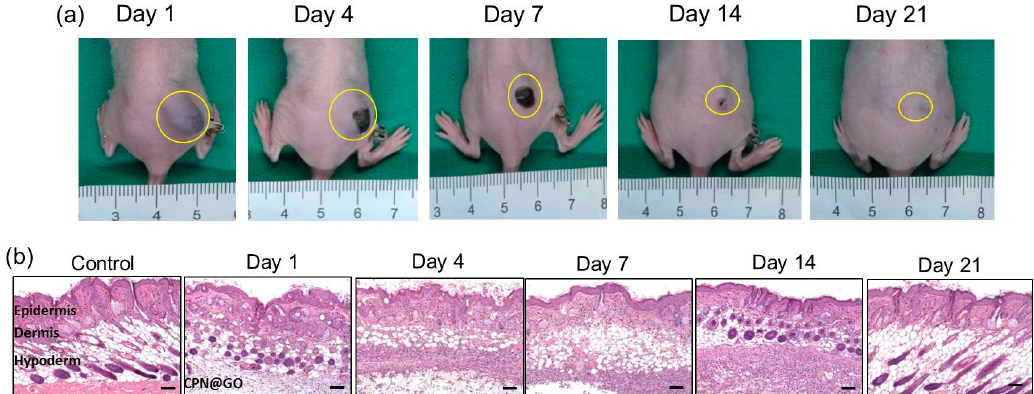
Figure 10. The in vivo degradation of CPN@GO hydrogel after the subcutaneous injection of a polymer solution containing 10% ( w / v ) CPN and 0.5% ( w / w ) GO to the right flank of a nude mouse. Gross view images were taken at different time points post-implantation ( a ), and the tissues surrounding the hydrogels were dissected and subject to hematoxylin–eosin (H&E) stain ( b ).